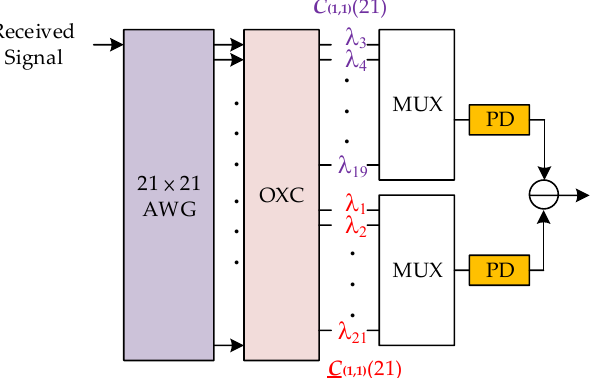
Figure 4. The decoder architecture of CMLS C (1,1) (21) based on AWG. Mux: Multiplexer. PD: Photodetector.